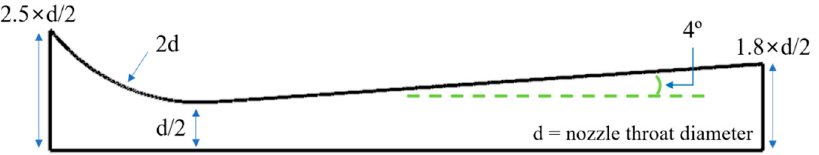
Figure 1. Toroidal-throat Venturi nozzle specified by ISO 9300.